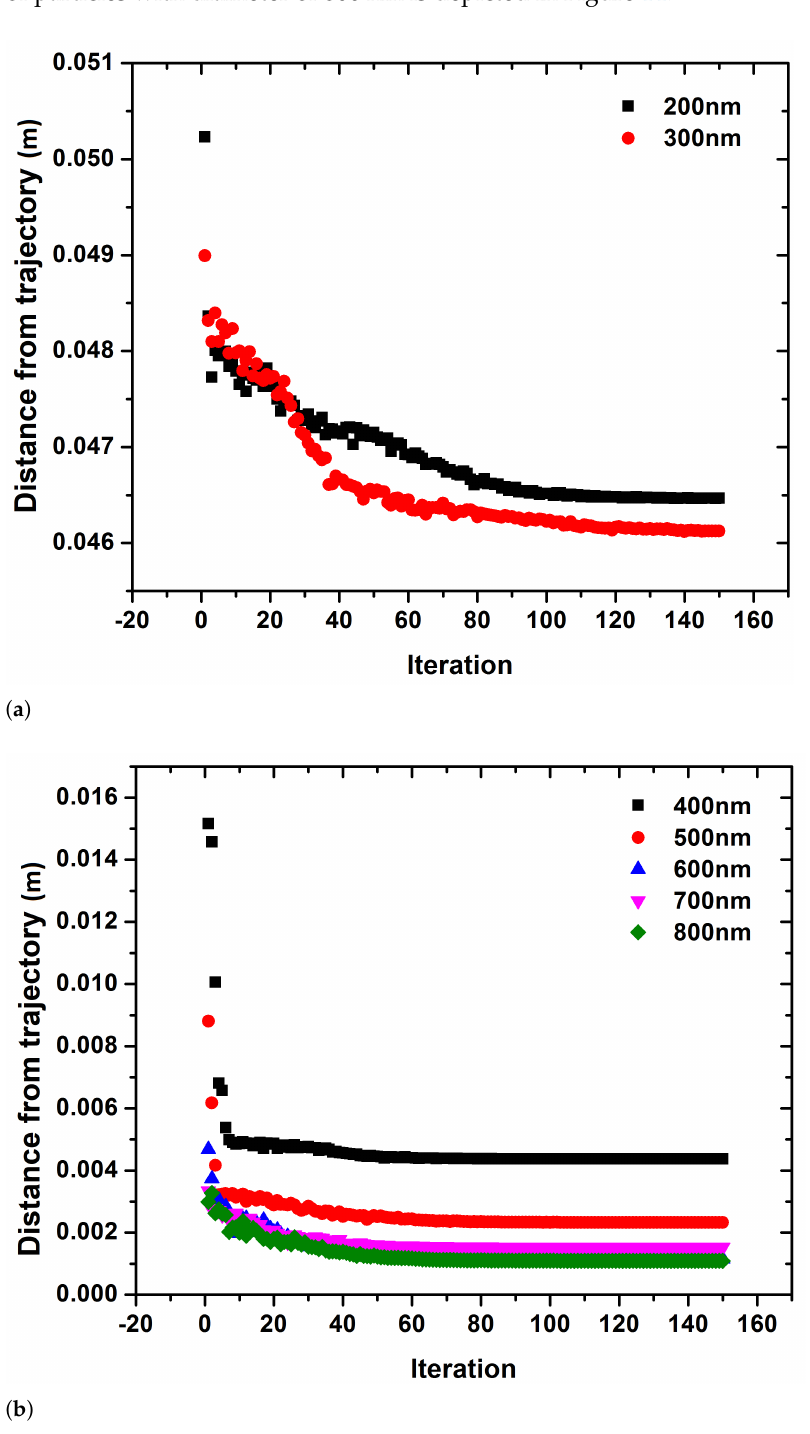
Figure 13. Distance of particles from the desired trajectory in each iteration of the computational method under inlet velocity of 0.08 m/s in the minimized carotid artery for the cases of ( a ) 200, 300 nm, and ( b ) 400 nm and